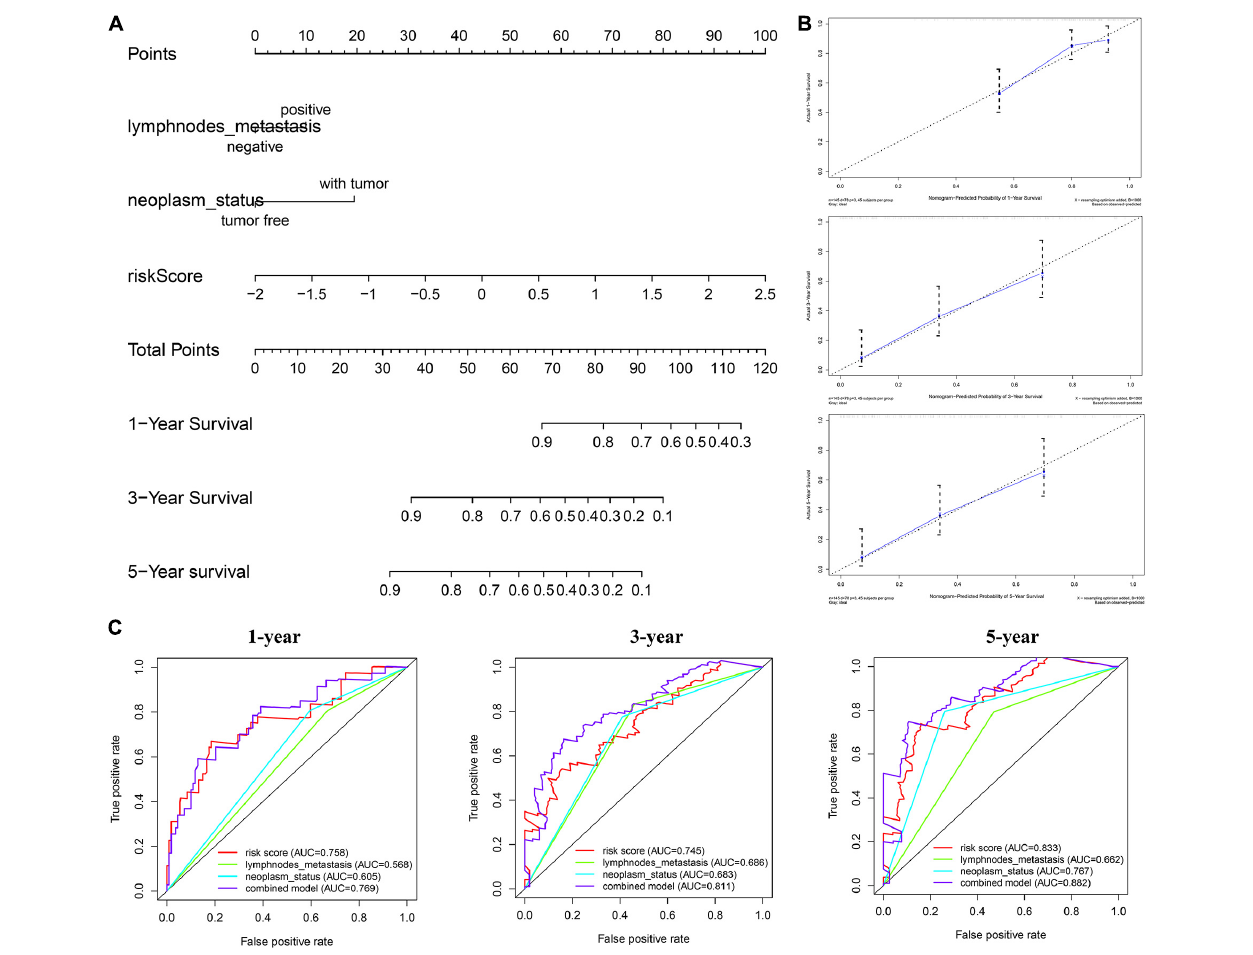
FIGURE 10 | Construction of combined prognostic model in TCGA cohort. (A) Nomogram for predicting the probability of 1-, 3-, and 5-year overall survival (OS) for pancreatic cancer patients. (B) Calibration plot of the nomogram for predicting the probability of OS at 1, 3, and 5 years. (C) Time-dependent ROC curve analyses of the combined prognostic